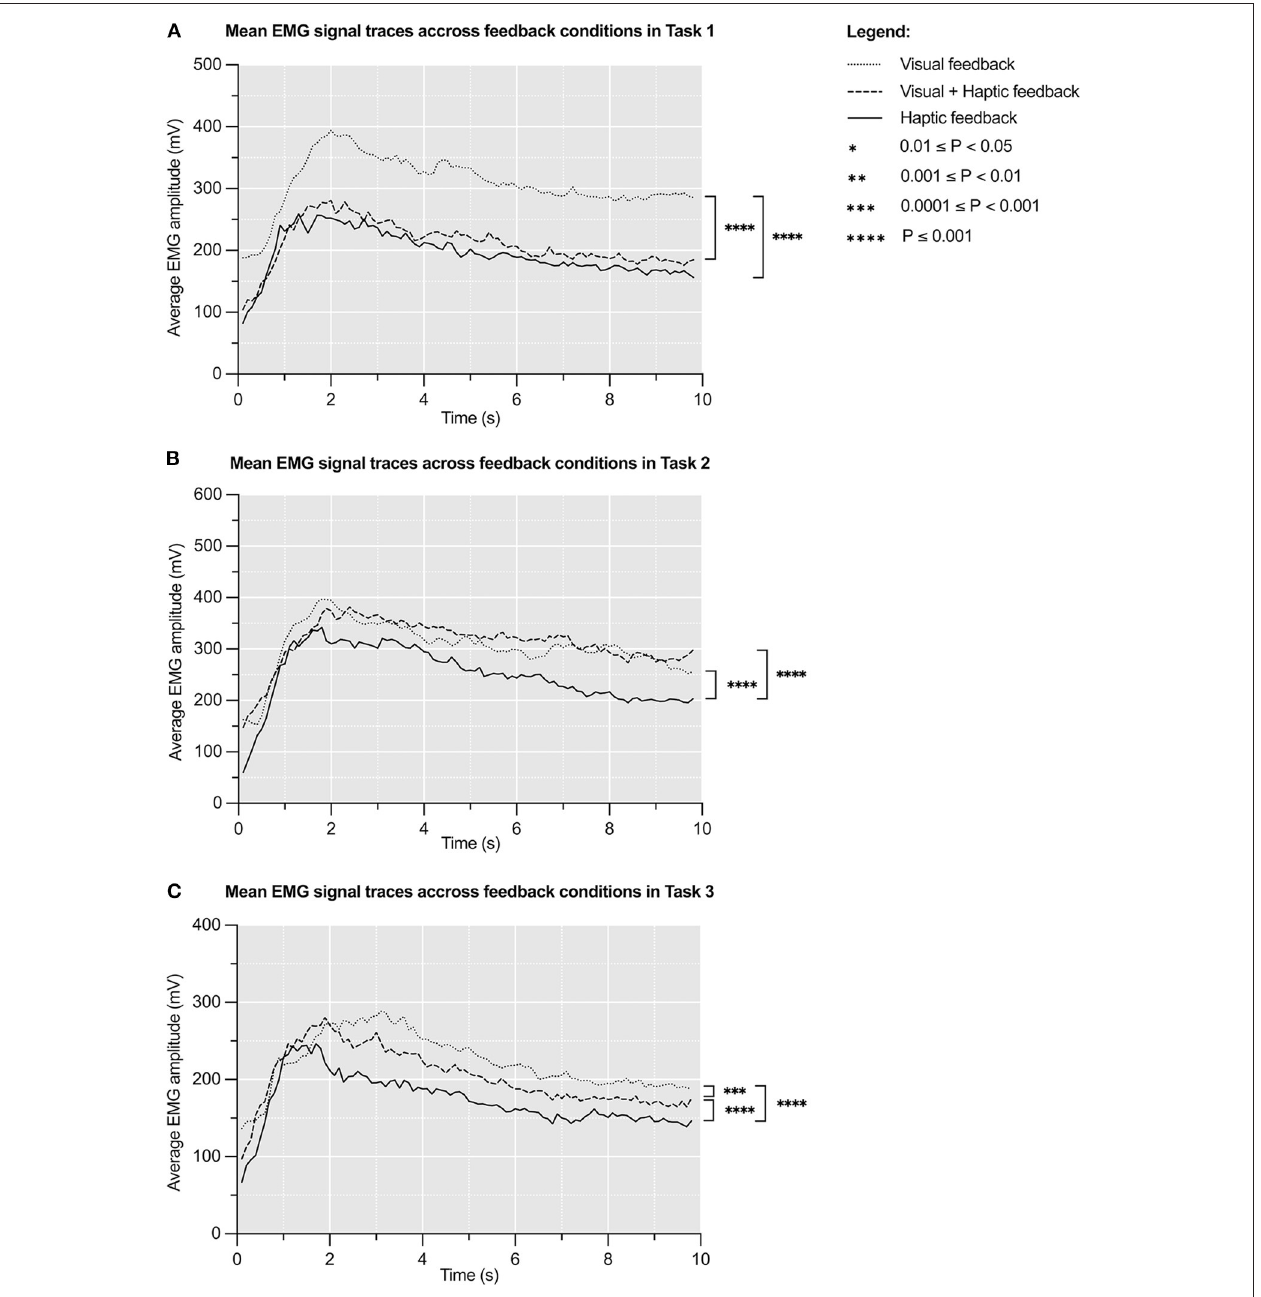
FIGURE 3 | Mean EMG signal (mV) traces over 10s across feedback conditions in Task 1 (A) , Task 2 (B) , and Task 3 (C) . The initial large peak corresponds to grasping the experimental object and the latter plateau corresponds to sustained grip. N =